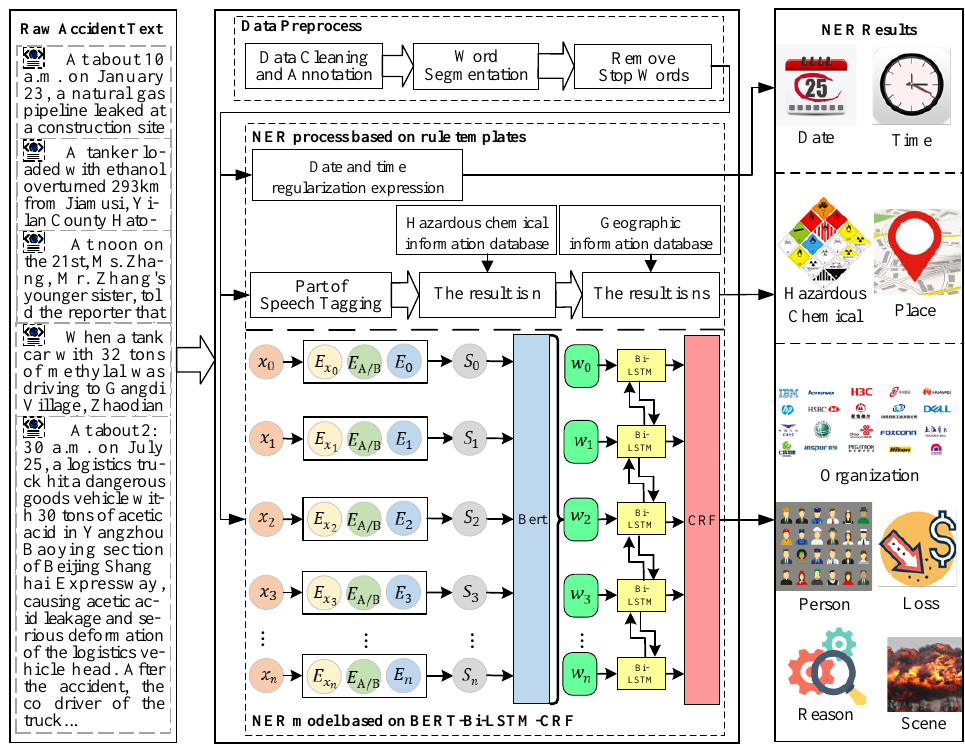
Figure 2. Named entity recognition